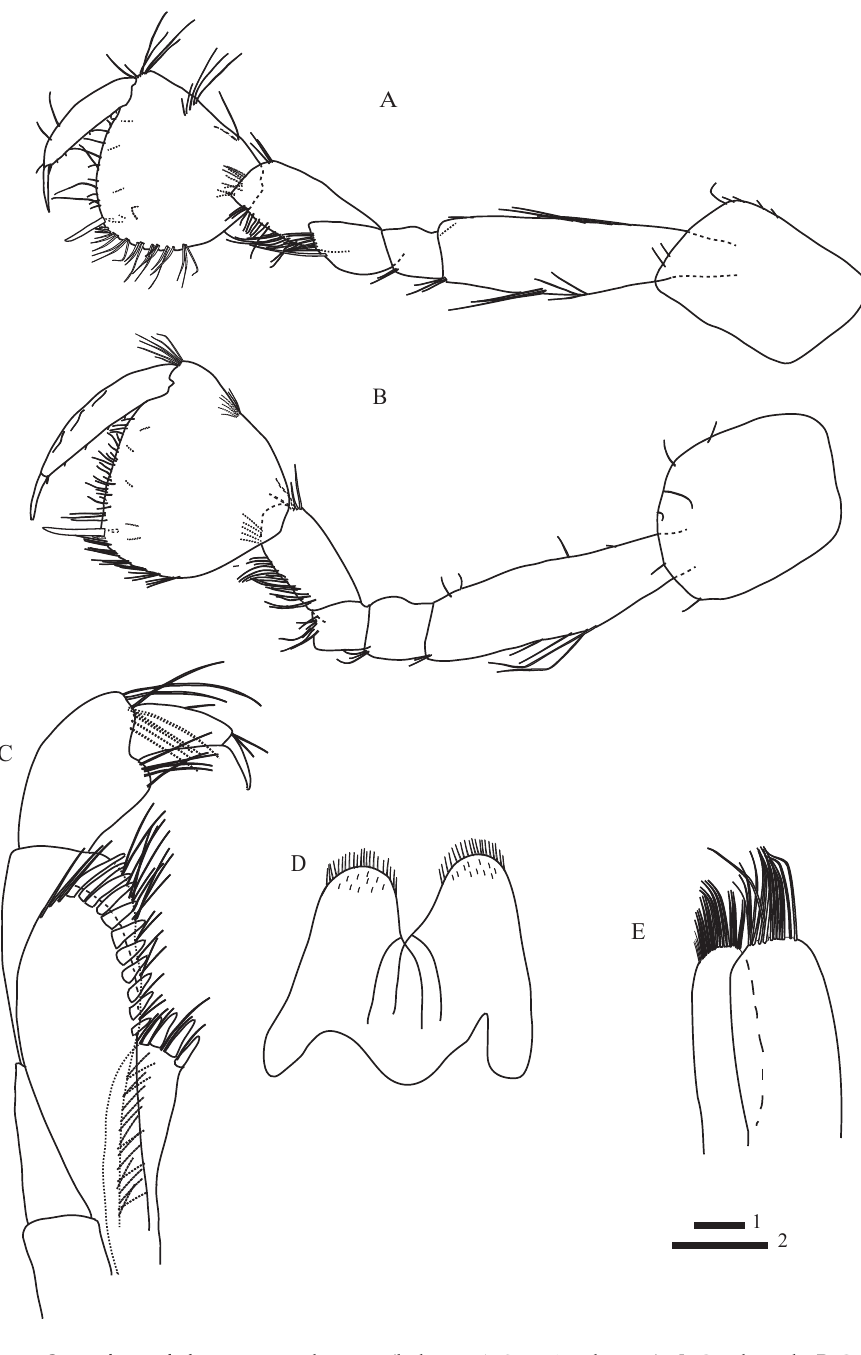
Figure 3. Niphargus hakani sp. n., male 9 mm (holotype, ZCRU Amph.1010). A Gnathopod I B Gna- thopod II C Maxilliped D Labium E Maxilla II. Scale bars: 1=0.5 mm ( C–E ). 2=1 mm ( A–B